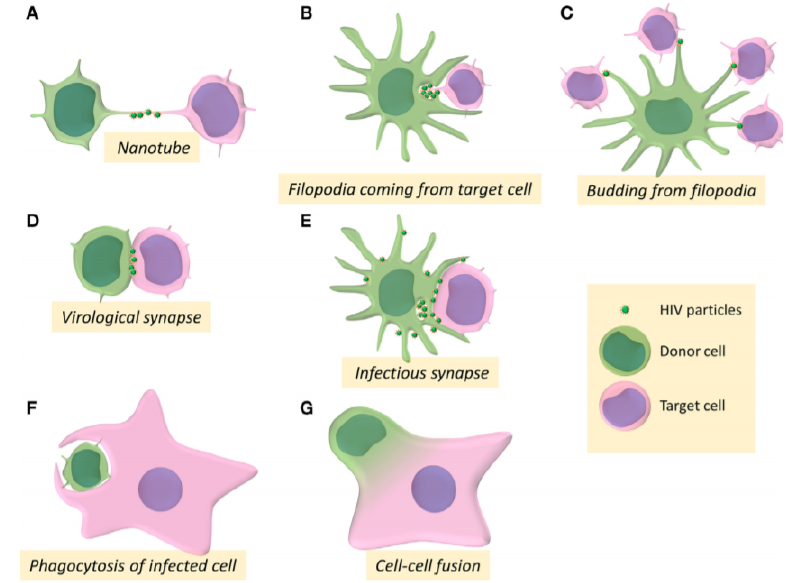
Fig. 1. Cellular Structures and processes involved in cell-to-cell transmission of HIV. Panels A-G show different pathways for HIV (green dots) cell-cell transmission between donor (green) and target (pink)